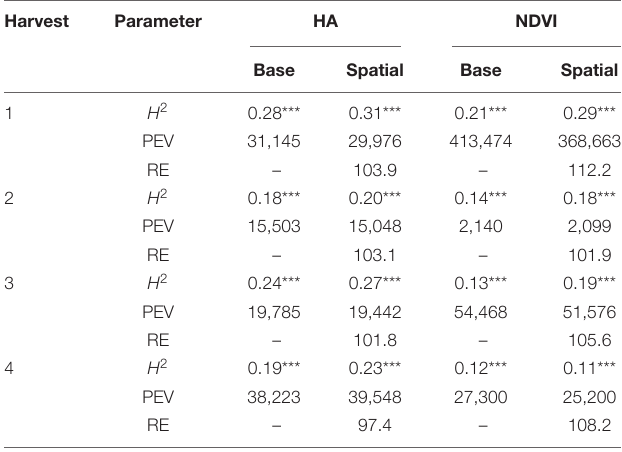
Linear mixed models were fitted for herbage accumulation (HA) and normalized difference vegetation index to estimate variance components in a model without accounting for spatial variation (base) and by modeling the spatial variation (spatial) in each harvest.